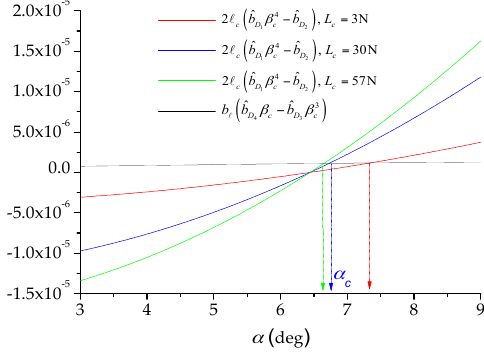
Figure 3. The variation of the sub-optimized propeller pitch command with the lift force command.